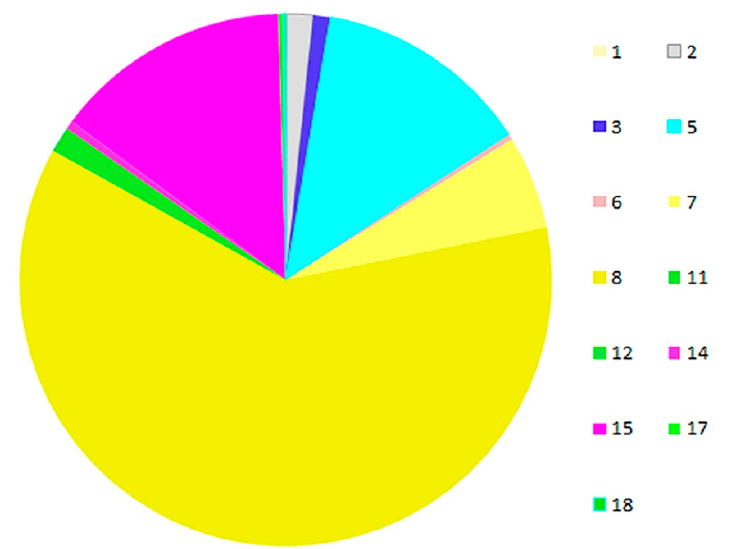
Figure 4. The proportion of new cultivated land in different vegetation types in Qing Dynasty. The vegetation numbers are same as (Table 3)